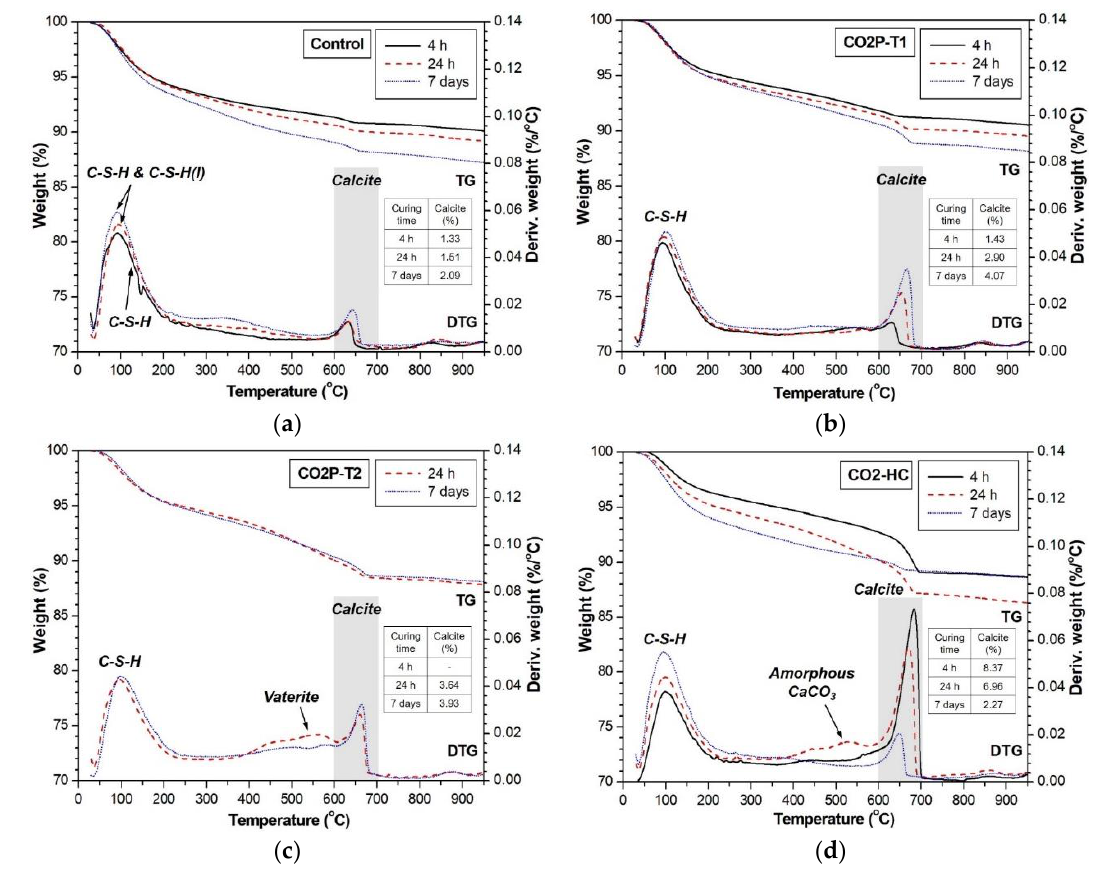
Figure 6. TG and derivative TG (DTG) curves of ( a ) control, ( b ) CO2P-T1, ( c ) CO2P-T2, and ( d ) CO2-HC samples with curing time.